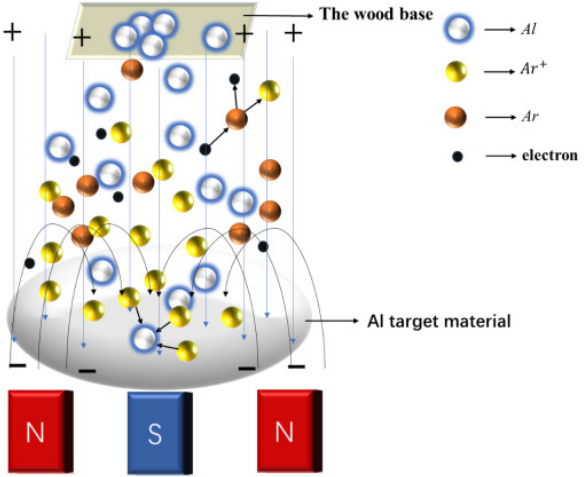
Figure 1. Schematic diagram of nano-Al metallized wood constructed by magnetron sputtering (“N” and “S” aremagnetic poles, “+” is the anode and “ − ” is the